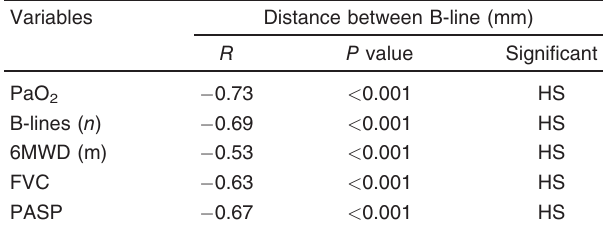
Table 6 Illustrate correlation of distances between B-lines (mm) and other variables among cases